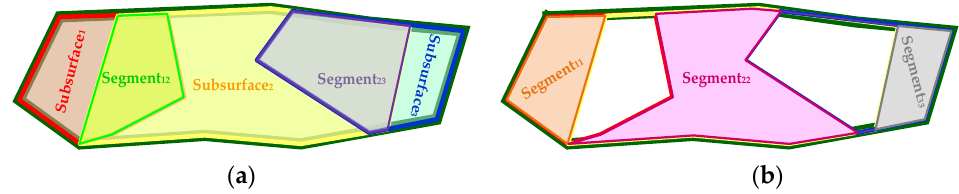
Figure 15. Visible segments in ( a ) multiple images (segment 12 and segment 23 ) and ( b ) in a single image (segment 11 , segment 22 , and segment 33 ).